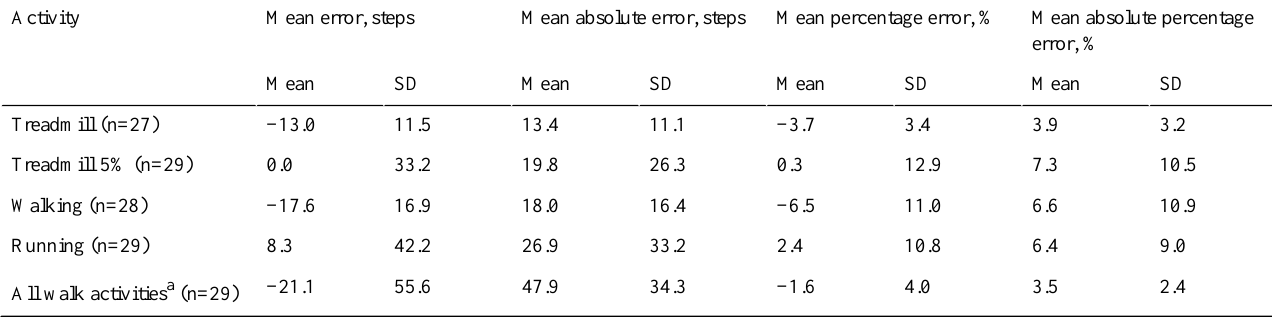
Table 6. Errors in step count estimation when compared with the waist-mounted reference, based on the total number of steps for each activity.